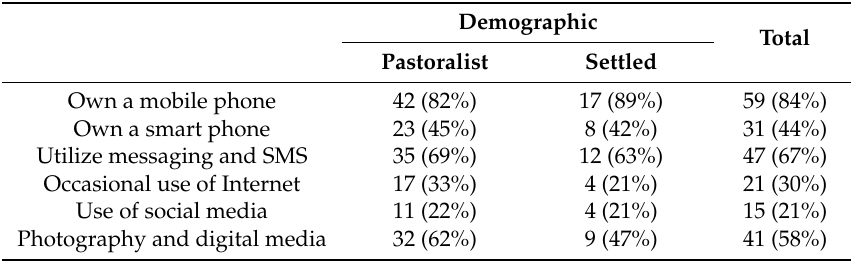
Table 5. Mobile phone use within local communities at